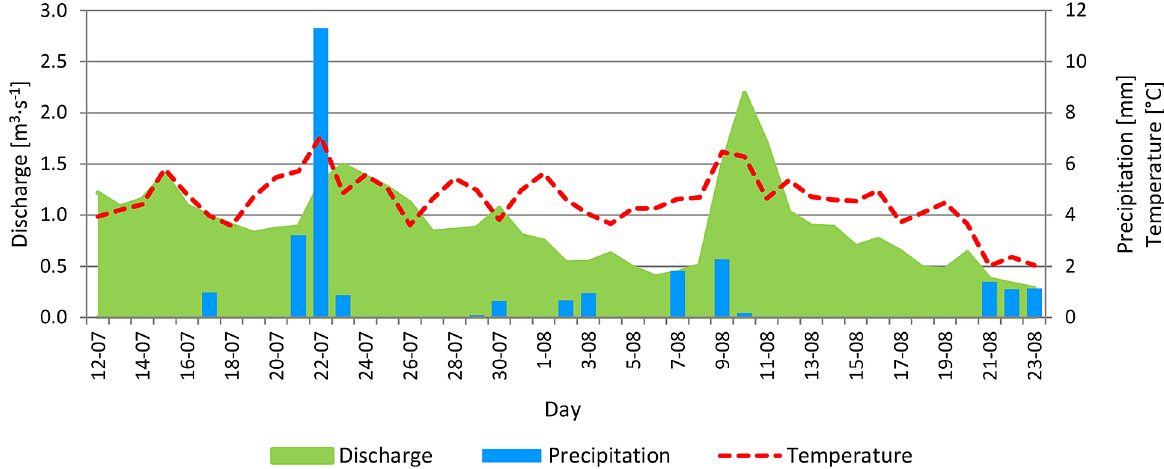
Fig. 3. Course of mean daily discharges in the Scott River in comparison to daily precipitation and air temperature in the measurement period 2012.